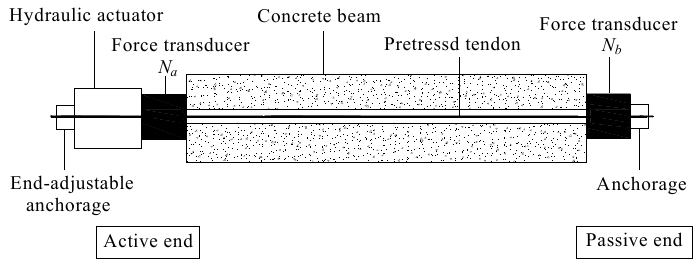
Figure 9. Measurement program for κ and μ .